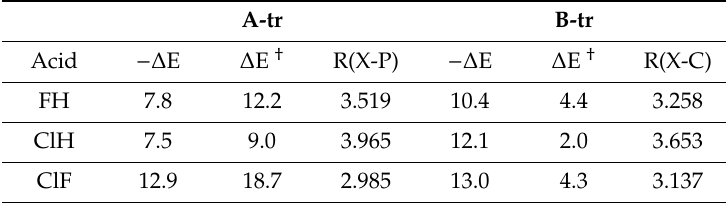
Table 7. Binding energies (– Δ E), barriers ( Δ E † , kJ·mol –1 ), and intermolecular distances (R,Å), for the